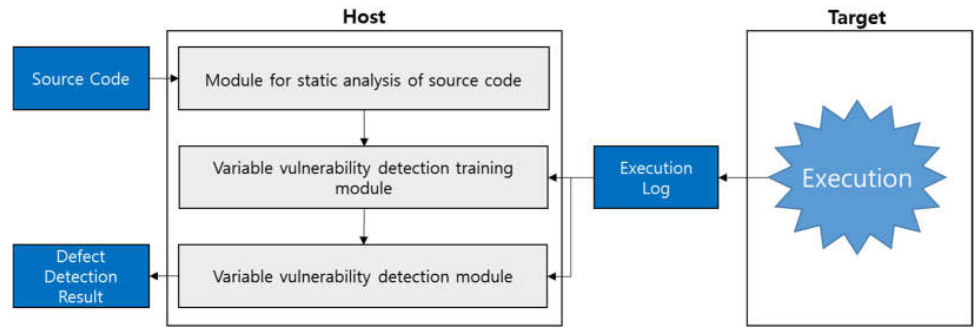
Figure 7. VVDUM (Variable Vulnerability Detector Using Machine learning).